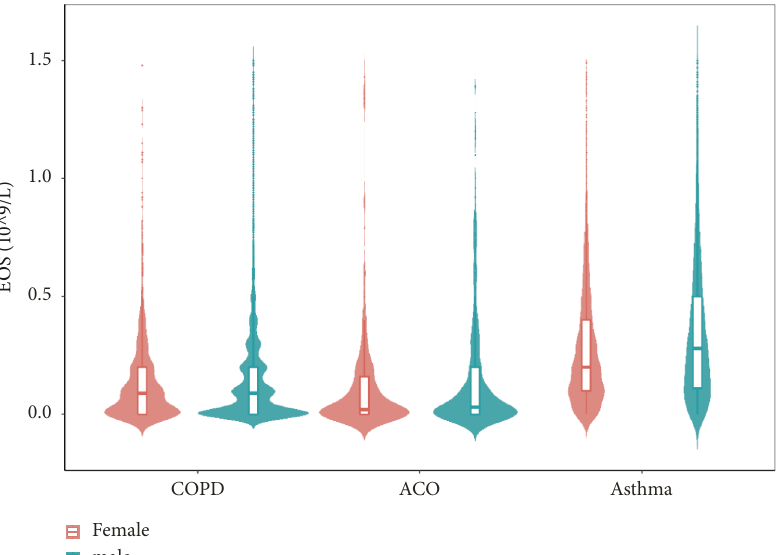
Figure 3: Distribution of eosinophils by gender in the three diseases. (COPD, chronic obstructive pulmonary disease; ACO, asthma-COPD overlap; EOS,